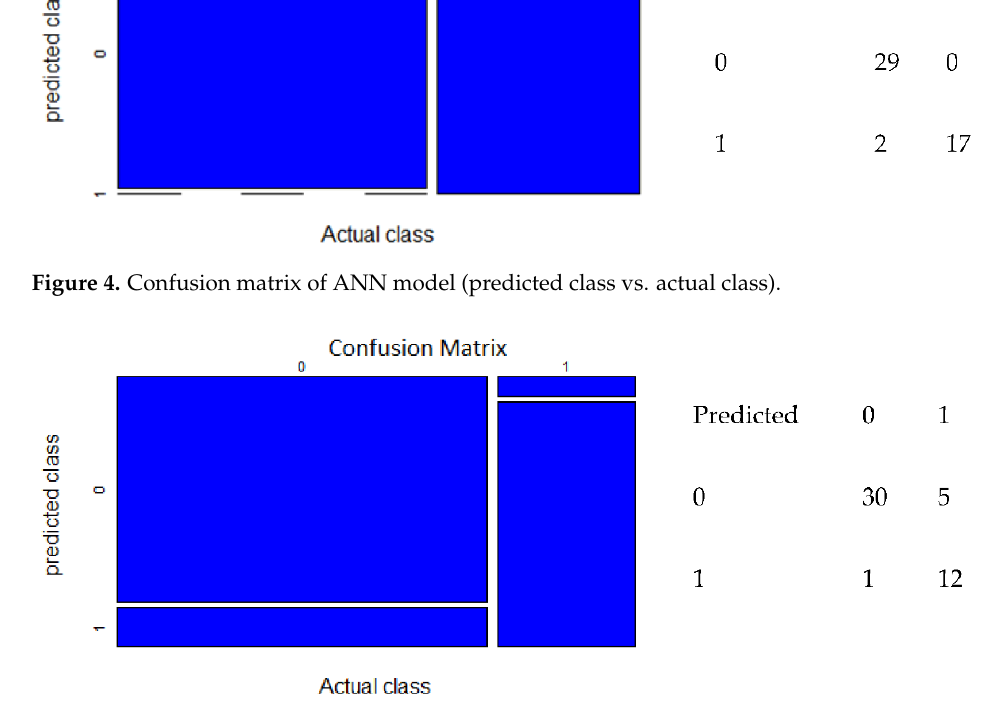
Figure 5. Confusion matrix of RF model (predicted class vs. actual class).